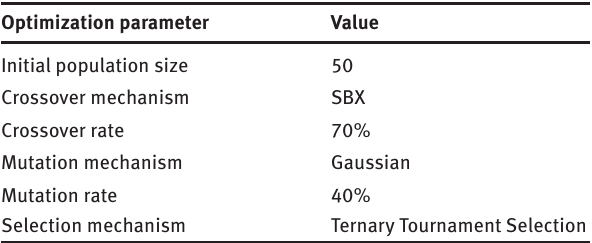
Table 1. The code was then implemented to find fitness of each chromosome to simultaneously optimize toner properties. After giving pairs of chromosomes were compared together, they were isolated from the remainder, as the first Pareto front. This operation was surveyed to obtain Pareto fronts 2, 3, etc. Pareto front n was assigned to the chromosome that has been dominated ( n -1) times. We also used crowding distance ( C . D .) values, as the second criterion for optimization, was to sort Pareto fronts: